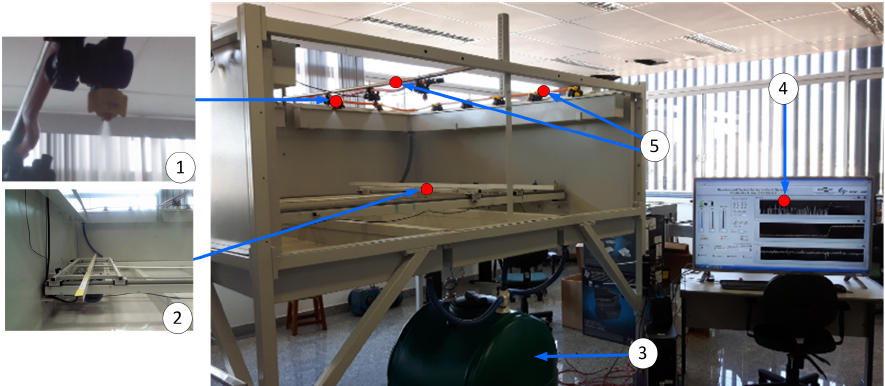
Figure 4. Development system for projects dedicated to the application of liquid agricultural inputs: